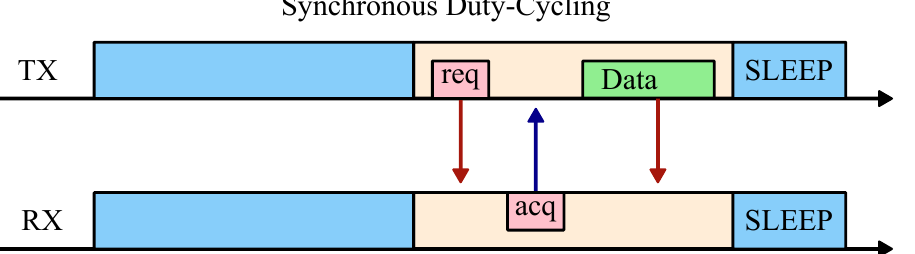
Figure 6. Illustration of synchronous vs. asynchronous duty-cycling. In the asynchronous case, request packets (req) must be sent continuously by the sender until the receiver responds with an acknowledge packet (ack) before communication can take place. In the synchronous case, the active and sleep regions are aligned based on a synchronization